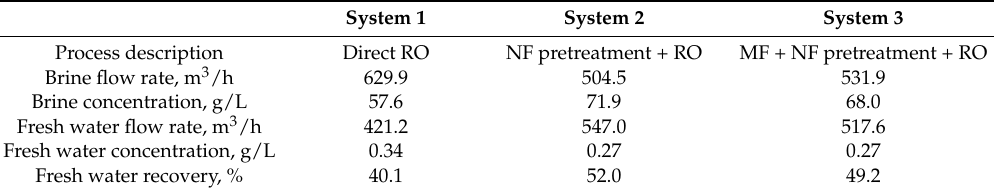
Figure 9. Schematics of integrated SWRO units without ERDs. Table 5. Seawater flow rates, concentrations, and freshwater recovery